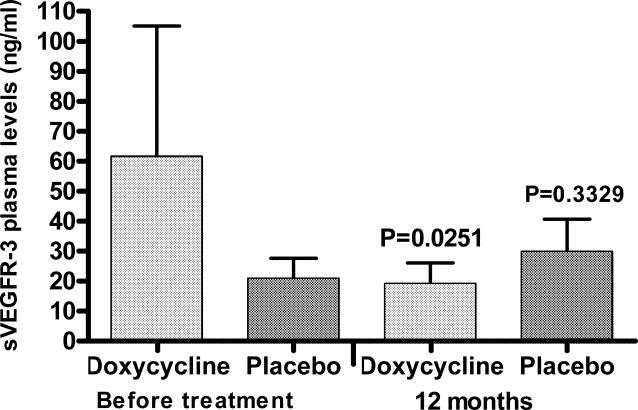
Plasma Levels of sVEGFR-3 of Lymphedema Patients before and 12 Mo after Doxycycline TreatmentPlasma concentrations (mean ± SD) of sVEGFR-3 were measured from plasma of lymphedema patients before and 12 mo after doxycycline treatment. The sVEGFR-3 levels decreased significantly at 12 mo in the doxycycline-treated patients (p = 0.0251) whereas there was no difference in the placebo group (paired t-test).